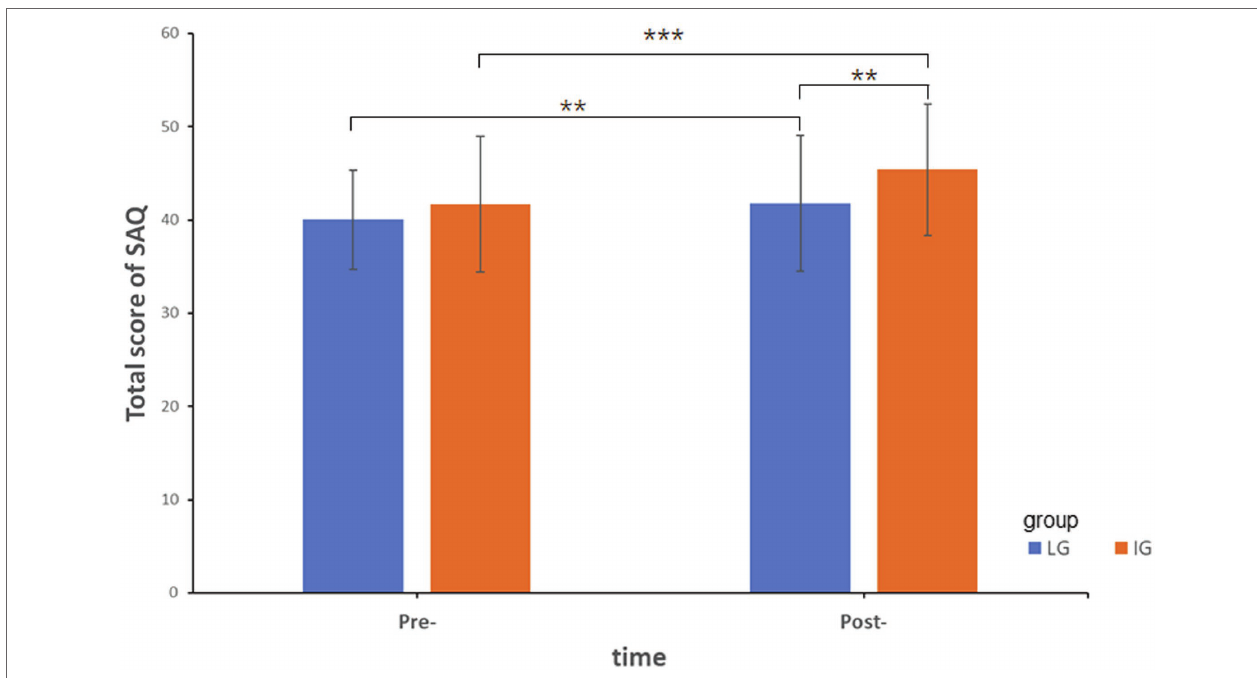
FIGURE 1 | The intervention effect for total score of SAQ. ** p < 0.01; *** p <